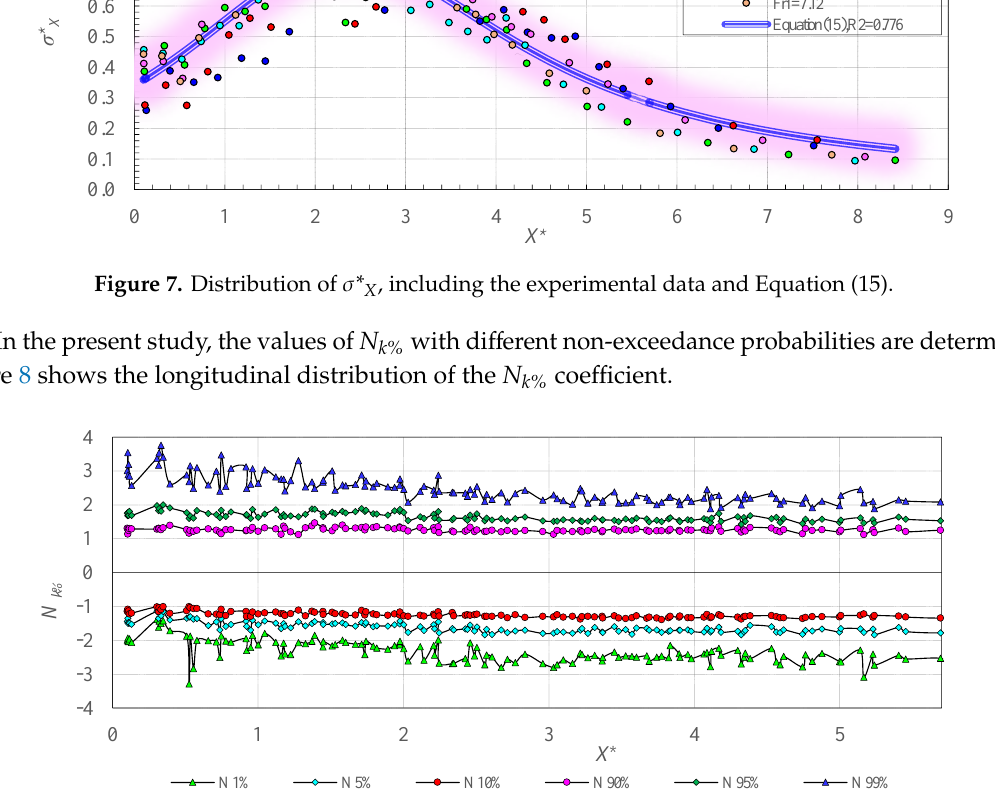
Figure 8. Distribution of the N k% coefficient for different probabilities.